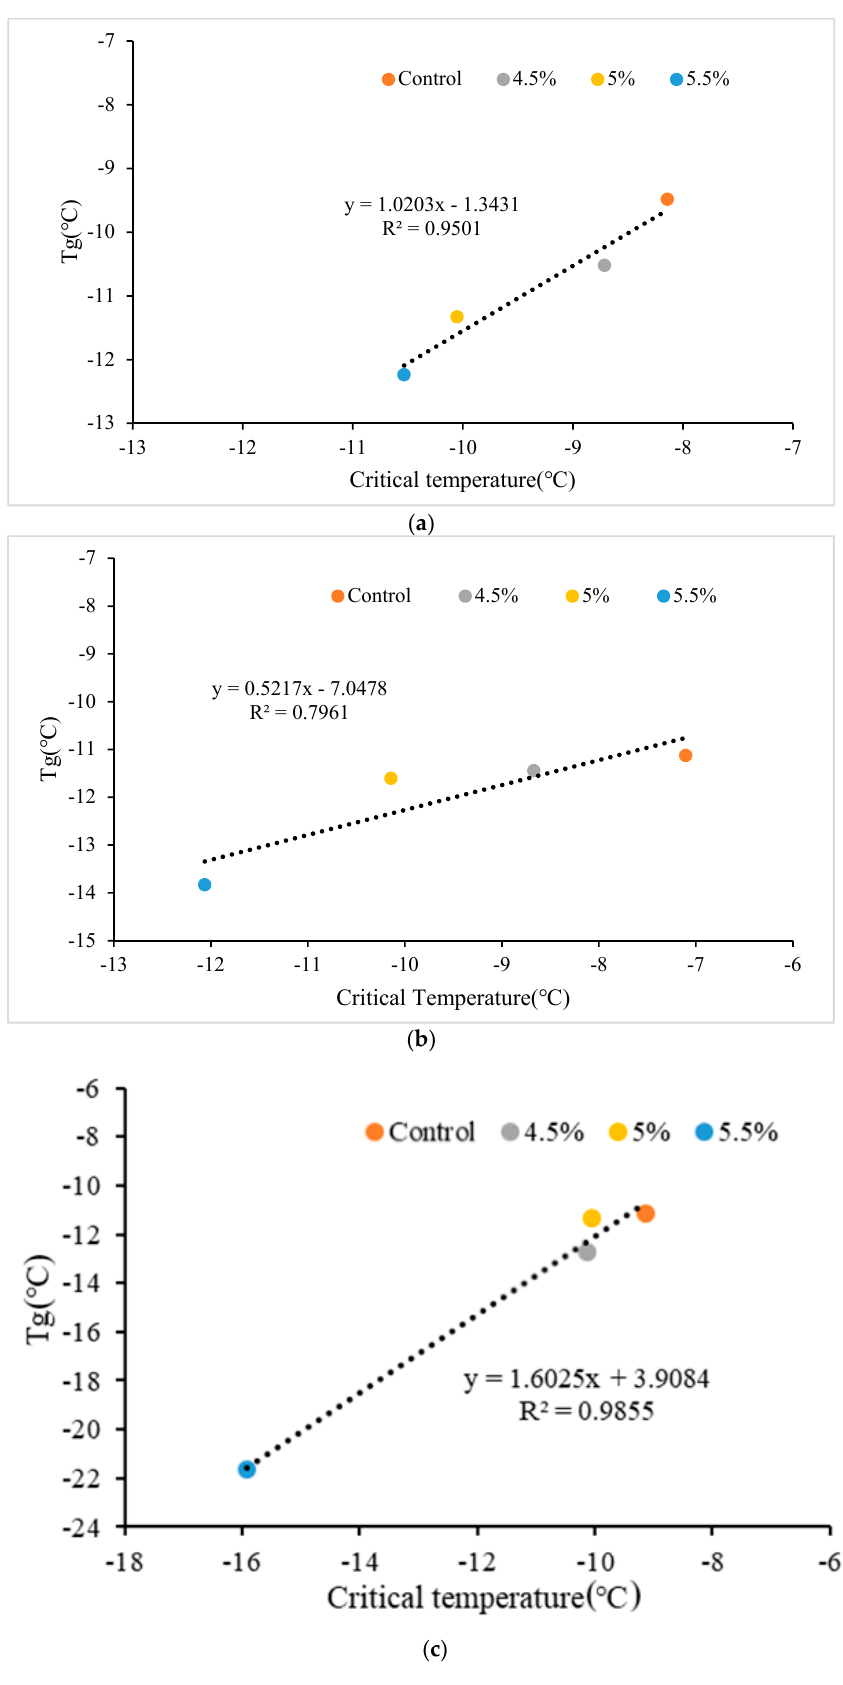
Figure 6. The relationship between critical temperature and T g ( a ) A70., ( b ) B70, ( c ) C90. In order to further illustrate the relationship between critical temperature and the T of SBS asphalt modified with different asphalt sources, the SBS asphalt modified with g different asphalt sources should be analyzed. It can be seen from Figure 7 that the corre- lation coefficient, between the critical temperature and T ified asphalt, was 0.93, which is greater than 0.632 (the confidence degree is 95%, and the degree of freedom was 10), indicating that there was a significant correlation between the critical temperature and T g of the three kinds of SBS modified asphalt. Moreover, it could be seen intuitively that the low temperature performance of the C90 SBS modified asphalt was better than that of A70 and B70 SBS modified asphalt. It can be seen from Figure 7b that, with the increase of SBS content, the critical temperature and T g of the SBS modified asphalt obviously decreased. Therefore, the influence of the SBS content on its low temperature performance was very significant, and the SBS asphalt modified by adding 5.5% of SBS content had the best low temperature performance. As the glass tran- sition temperature had a clearly physical significance, it could characterize the difference in low-temperature performance between different asphalt sources and different SBS con- tents, and the evaluation results had a significant correlation with the critical temperature of the low temperature creep of the SBS modified asphalts (the confidence level is 95%). As a result, the data obtained by DSR experiments to calculate the glass transition tem- perature could be evaluated for the low temperature properties of the SBS modified as- phalts. The method could not only reduce the workload of low temperature performance tests, it also provided strong and complementary evidence to evaluate the low tempera- ture performance of asphalt materials.